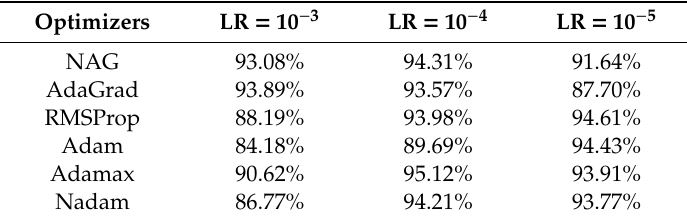
Table 5. Results obtained with the DenseNet architecture. Where LR represents learning rate; NAG represents Nesterov momentum; AdaGrad represents the adaptive gradient optimizer; RMSProp represents the root mean square propagation optimizer; Adam represents adaptive moment estimation optimizer; AdaMaxrepresentsmaximumadaptivemomentestimationoptimizer; andNadamrepresents Nesterov and Adam